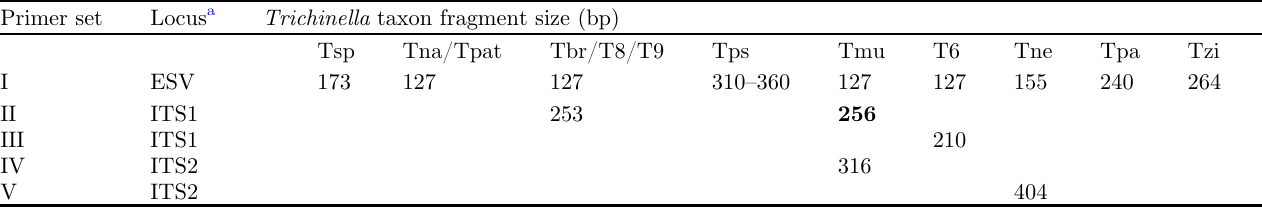
Table 1. Multiplex PCR fragment sizes of the 12 taxa of the genus Trichinella . Primer set